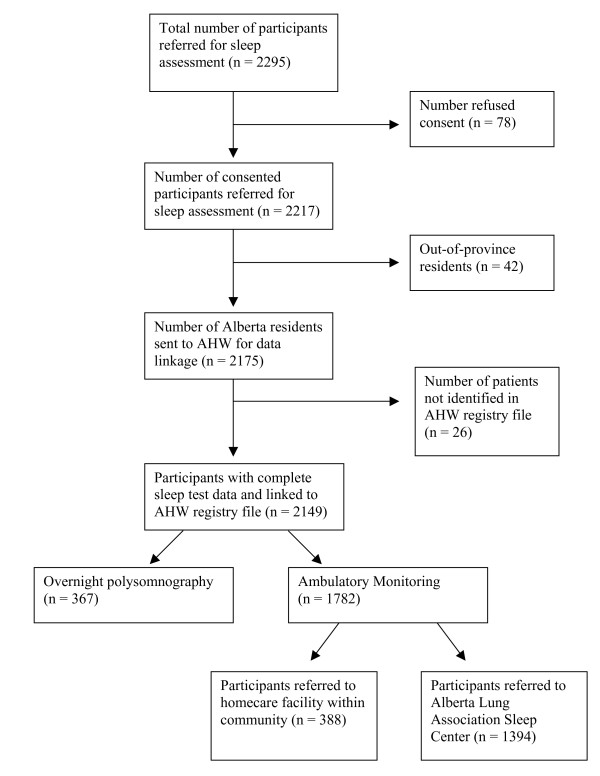
Patient Flow Diagram.